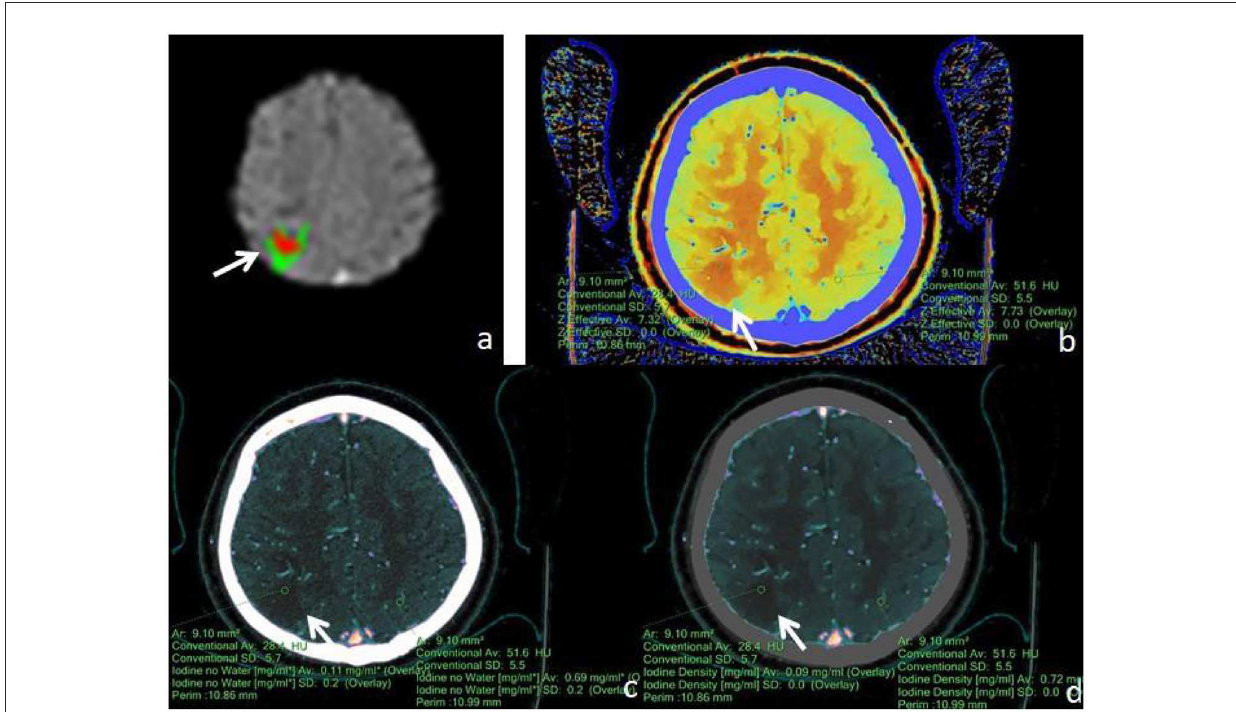
FIGURE2 Male, 77 years old, was found with angular drooling and left-sided limb weakness for 6h. (a) F-STROKE automated perfusion analysis software showed right parietal AIS with CBF < 30% = 4.2mL and T max > 6S = 12.7mL. (b–d) Zeff maps, iodine density maps, and iodine–no-water maps, respectively, with arrows indicating ischaemic areas in the right parietal lobe. (b) Measurement of an ischaemic area in the right parietal lobe with a Zeff value of approximately 7.32, and a corresponding Zeff value of approximately 7.73 in the contralateral non-ischaemic area. (c) Measurement of an absolute iodine value of approximately 0.11 mg/mL in the ischemic area of the right parietal lobe and a corresponding iodine–no-water value of approximately 0.69 mg/mL in the contralateral non-ischaemic area. (d) The iodine density value in the ischaemic area of the right parietal lobe was measured to be about 0.09 mg/mL, and the corresponding value in the contralateral, non-ischaemic area was measured to be about 0.72